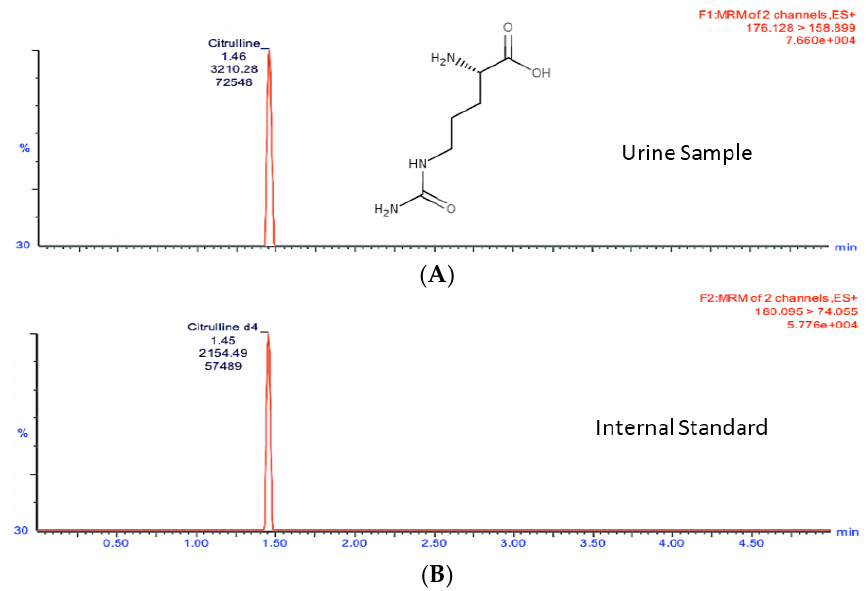
Figure 2. Representative UPLC-MS/MS chromatograms of endogenous urinary citrulline detected at 91.5 ng/mL and citrulline-d 4 at 150 ng/mL (Internal Standard). The retention time is presented on the x -axis and the y -axis represent the ion count for the channel. The mass charge ratio of the parent and daughter ions, as well as the ion count for each channel is shown. The peaks represent the most abundant ions that were used for quantification. Multiple reaction monitoring (MRM) transition chromatogram of ( A ) m / z 176.1 → 158.9 for citrulline and ( B ) m / z 180.1 → 74.1 for spiked neat internal standard citrulline-d 4 used for quantitation.